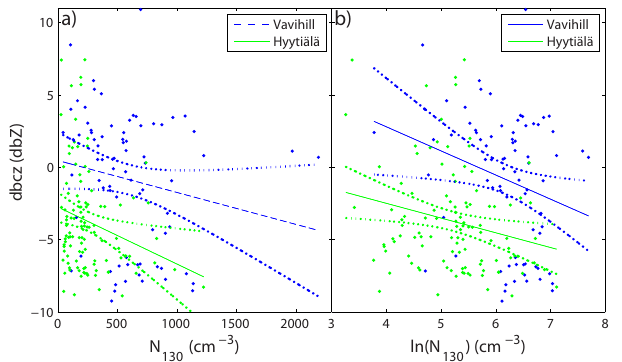
Figure 8. Radar reflectance (dbcz) as a function of aerosol number concentrations above 130nm (N 130 ) for only precipitating cases. In (b) , the natural logarithm has been applied to the N 130 . The dotted lines represent the 95% prediction intervals for the relationship of the combined data set.